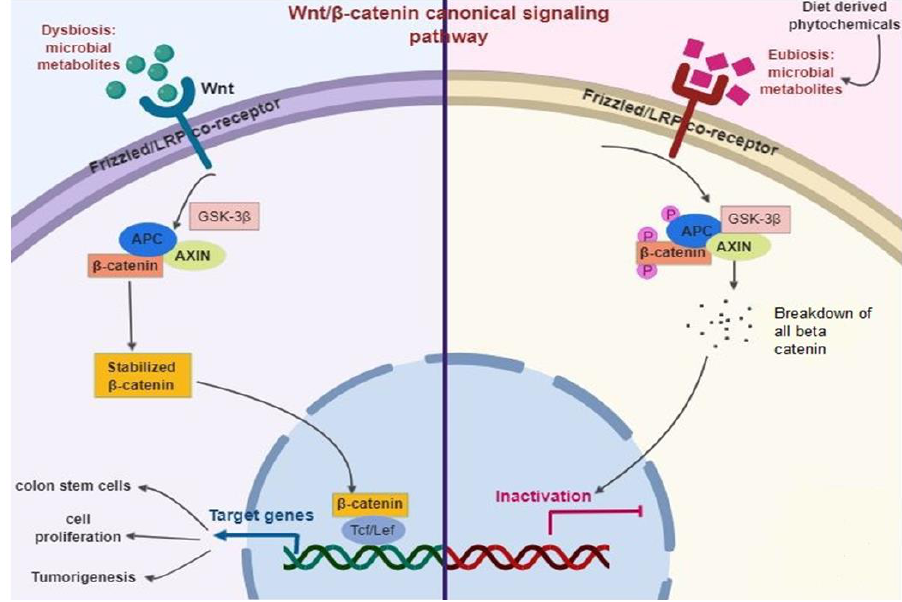
Figure 5. Diet-derived phytochemicals stabilize the microbiome status (Eubiosis) that inhibits Wnt/ β - catenin signaling pathways successively prevent intestinal infection and inflammation. Wnt / β -catenin signaling pathways successively prevent intestinal infection and